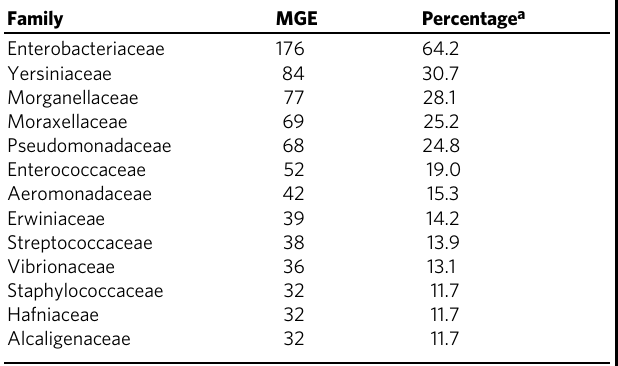
Table 2 Families with largest sets of transferable MGEs. Source data are provided in Supplementary Data 5 and